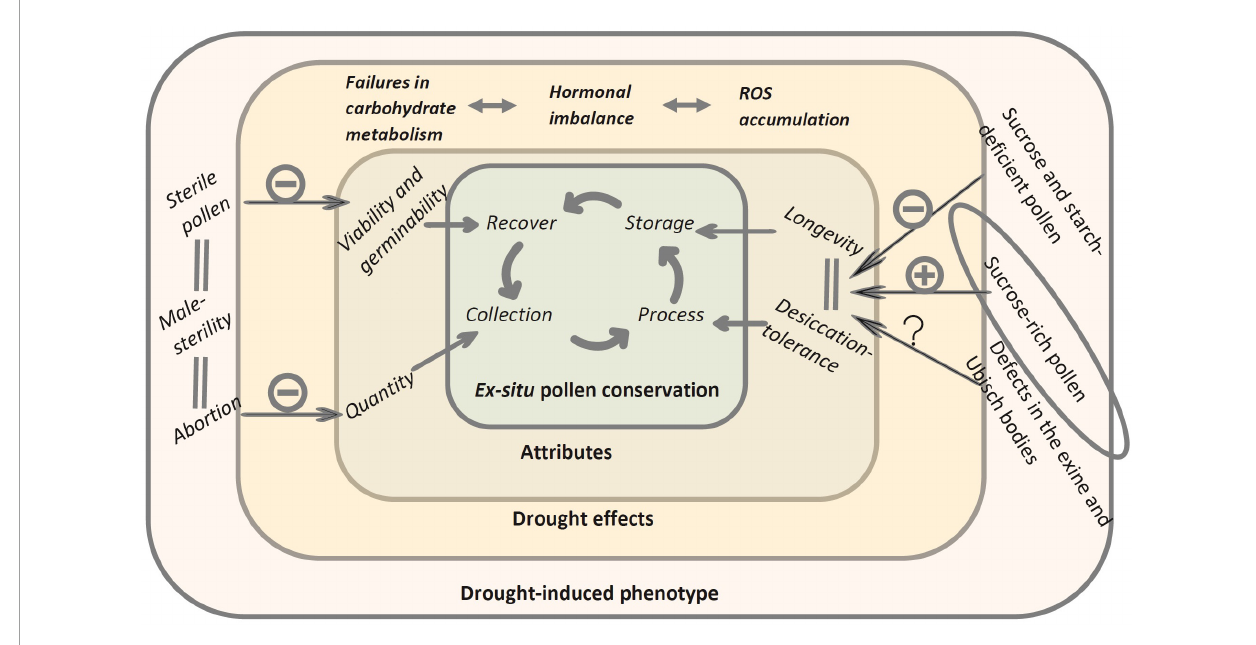
FIGURE1 Potential effects of drought-induced phenotypes on ex situ pollen conservation stages. Failures in the metabolism and delivery of assimilates and carbohydrates, hormonal imbalance, and collapse in maintaining homeostatic balance to control ROS, result in (i) increased pollen abortion rates, affecting the amount available for collections, (ii) pollen with low sucrose and starch content, which has been related to lower longevity and tolerance to desiccation, directly affecting the suitability of pollen to resist the drying process and storage, (iii) defects in the exine and Ubisch bodies, which is hypothesized could affect the resistance of the pollen grain to desiccation and changes in internal pressure, as well decreasing its aptitude as an explant to be cryopreserved, and (iv) increased pollen sterility, impacting its germination ability and ultimately, being unable to recover for fertilization. In a separate case within an elliptical figure, drought stress within tolerable ranges for the plant, which it is capable of coping with, could be beneficial by increasing the sucrose content of the pollen, increasing its longevity, and working as a precondition for its desiccation. (–) Decrease suitability; (+), increase